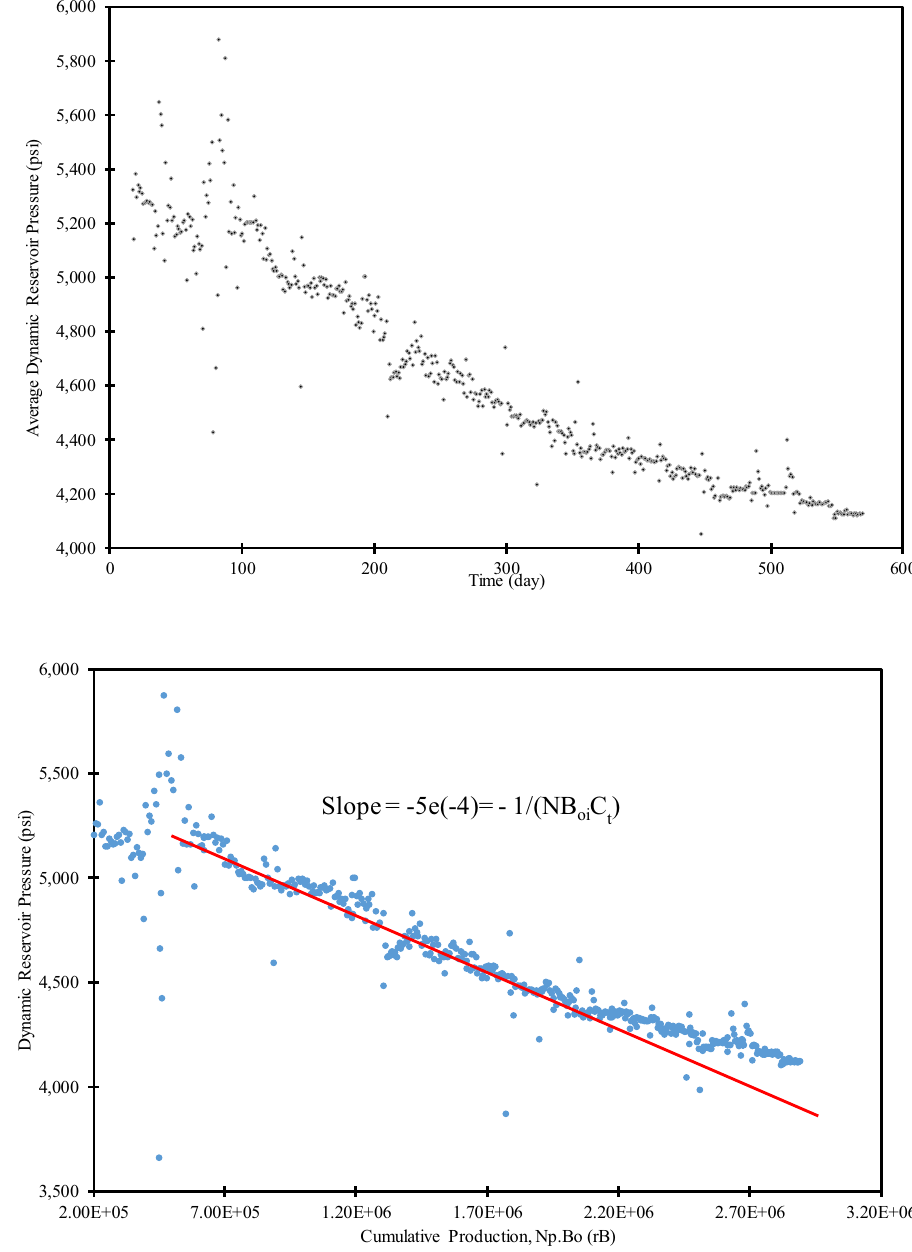
Fig. 6 Estimation of oil in place in drainage area of producer well